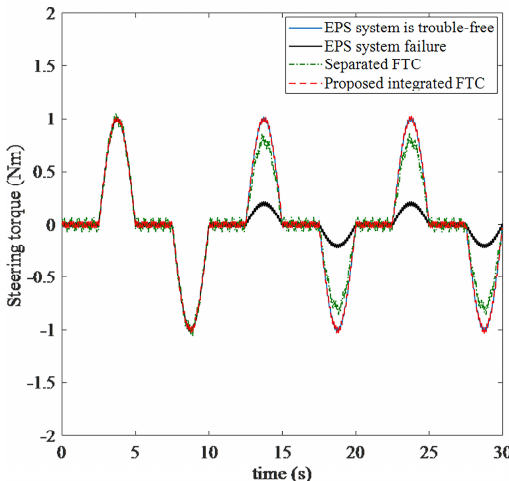
Figure 10. Fault-tolerant control of the gain variation fault.